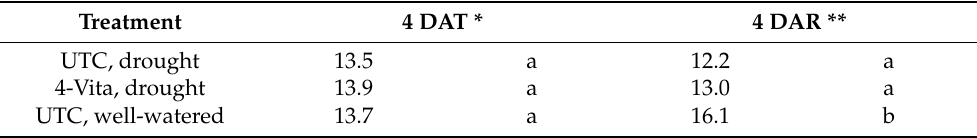
Table 3. Average of the fresh biomass (FB, g) of 6 plants per entry at 4 DAT and 4 DAR. For each trait, at least one letter in common indicates no significant